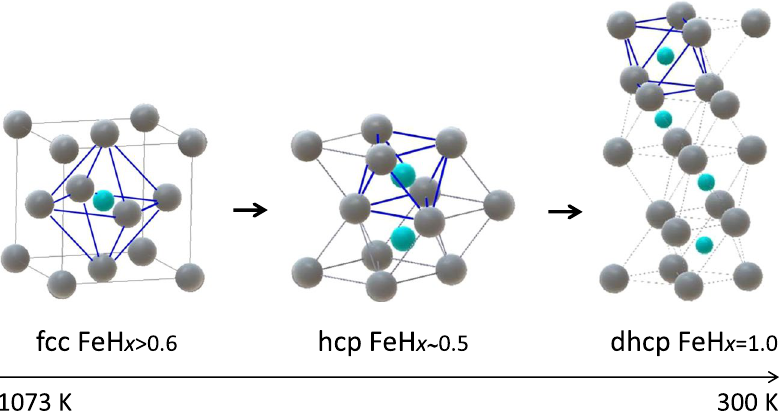
Figure 6. Crystal structures of fcc, hcp, and dhcp iron hydrides: grey and blue spheres represent Fe and H atoms, respectively; dissolved H atoms occupy the octahedral interstitial sites partially in the fcc and hcp hydrides and fully in the dhcp